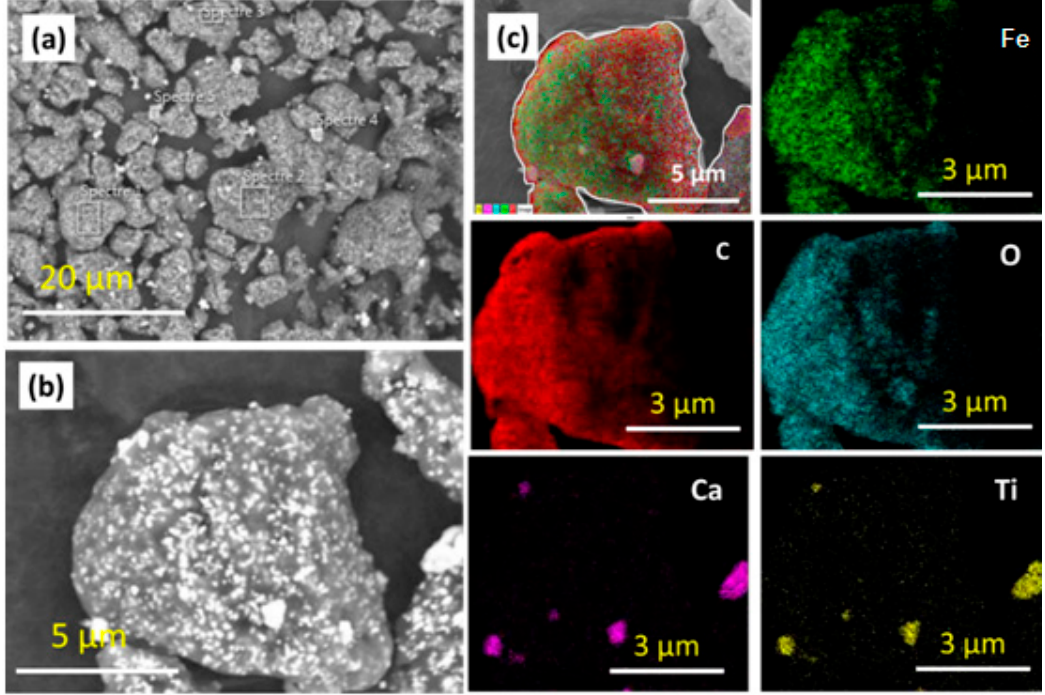
Figure 1. Scanning electron microscopy (SEM) image and energy dispersive x-ray map of TWP: ( a ) low-magnification SEM image; ( b ) high-magnification SEM image; and ( c ) energy-dispersive X–ray spectroscopy (EDS)-elemental mapping of TWP particles. Table 2. The elementary composition of TWP at different positions by EDS analysis.